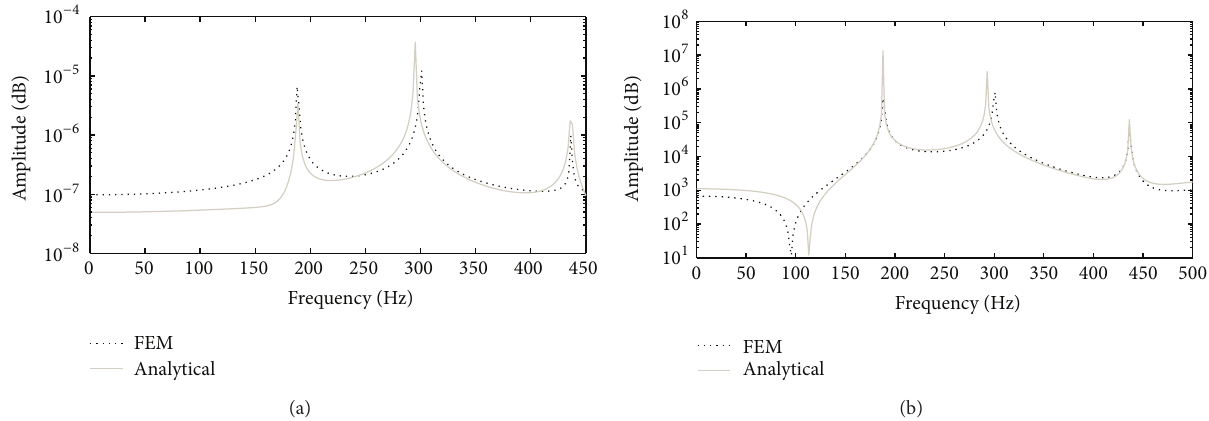
Figure 3: Panel dynamic response. (a) Mechanical excitation; (b) electrical excitation.